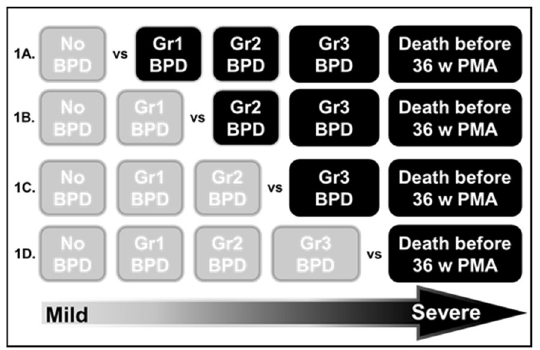
Figure 1. Binary classifications of various target outcomes. 1( A ): No BPD versus other conditions; 1( B ): Grade 1 BPD or no BPD versus other conditions; 1( C ): Death before 36 weeks’ PMA or Grade 3 BPD versus other conditions; 1( D ): Death before 36 weeks’ PMA versus other conditions; BPD Bronchopulmonary dysplasia; Gr Grade; PMA Postmenstrual age.